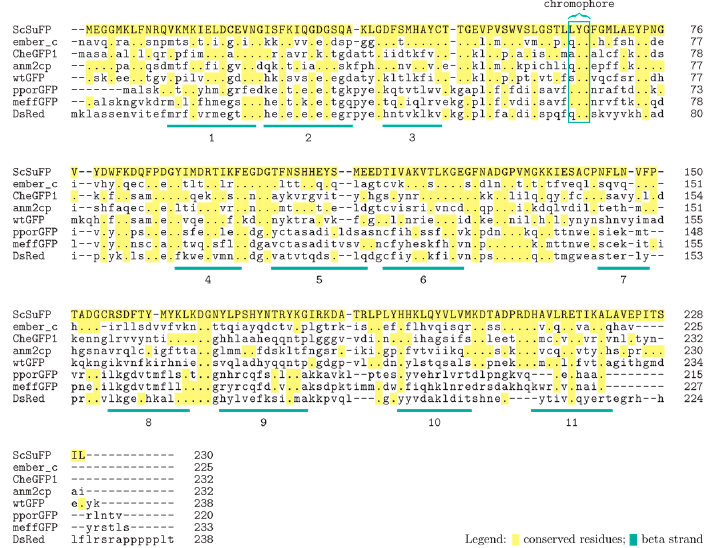
Figure 5. Alignment of the amino acid sequence of ScSuFP with ember_c, CheGFP1, anm2cp, wtGFP, pproGFP, meffGFP and DsRed. Identical amino acids are indicated with dots and highlighted with yellow color. Non-conserved residues are shown in lowercase and have no highlighting. The positions of chromophores are enclosed in a box. Beta-strands are underlined and numbered based on the wtGFP sequence. The alignment was made using Clustal Omega (Available online: https://www.ebi.ac.uk/Tools/msa/clustalo/) and the highlighting/labeling with TEXshade (Available online: https://www.uni-kiel.de/pharmazie/chem/Prof_Beitz/texshade.html) [24–26].